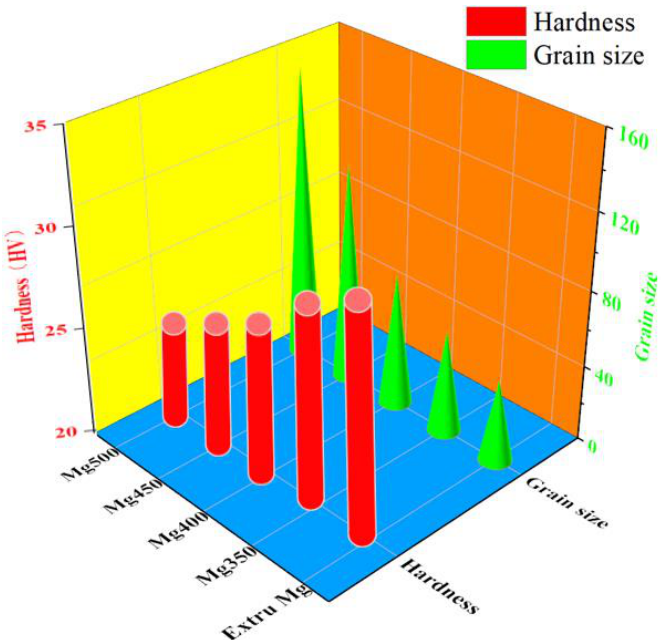
Figure 2. The average grain size and Vickers hardness at different annealed conditions (Mg350, Mg400, Mg450 and Mg500), with the extruded condition (Extru Mg) as a